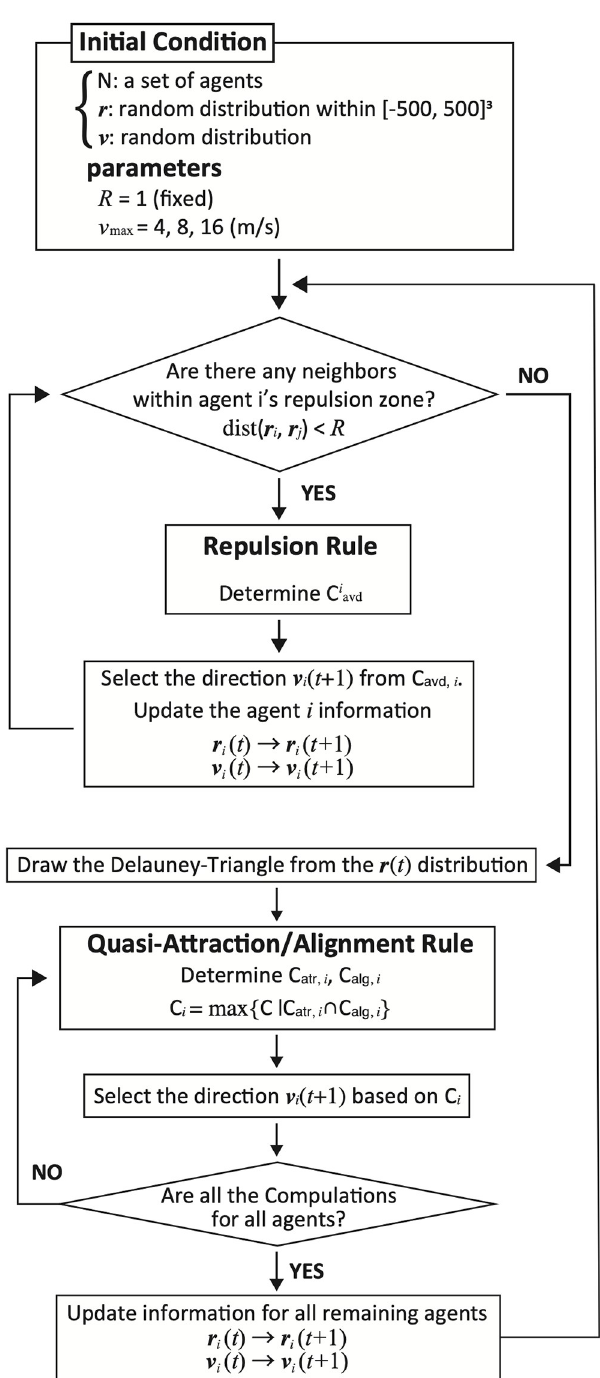
Fig 2. Overview of algorithm. One parameter (the maximum velocity v max ) exists when the repulsion radius R is fixed. Each agent checks if there are any other individuals in the repulsion zone, and if not, it executes the quasi- attraction/alignment rule. The update timings are synchronous. The algorithm framework is of the same type as those of previous Boids models and other methods.